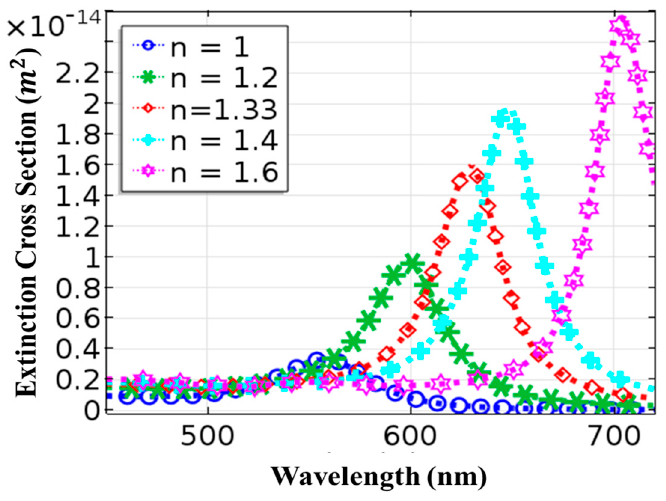
Figure 4. Change in extinction cross-section of the gold nanorods with incident wavelength for different refractive index values.